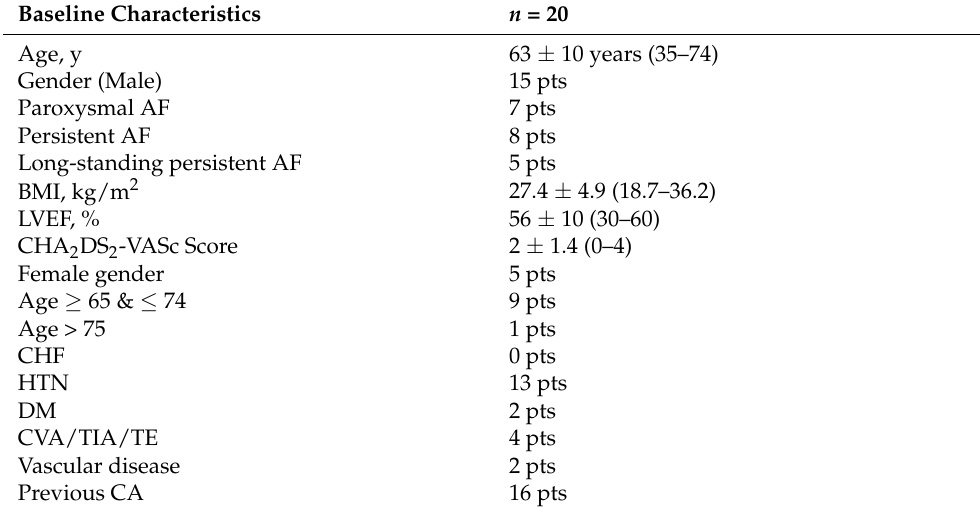
Table 1. Baseline clinical